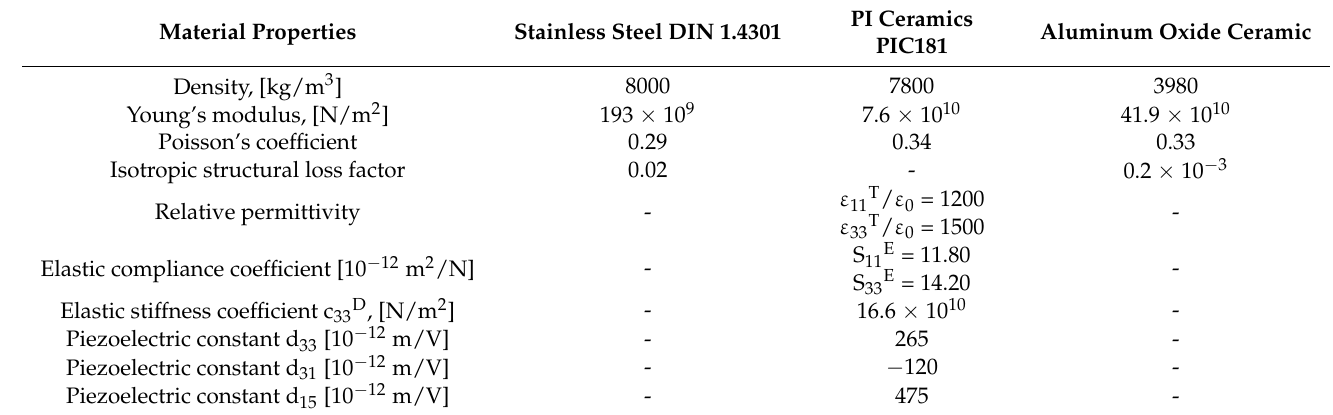
Table 2. Materials properties used in the model.